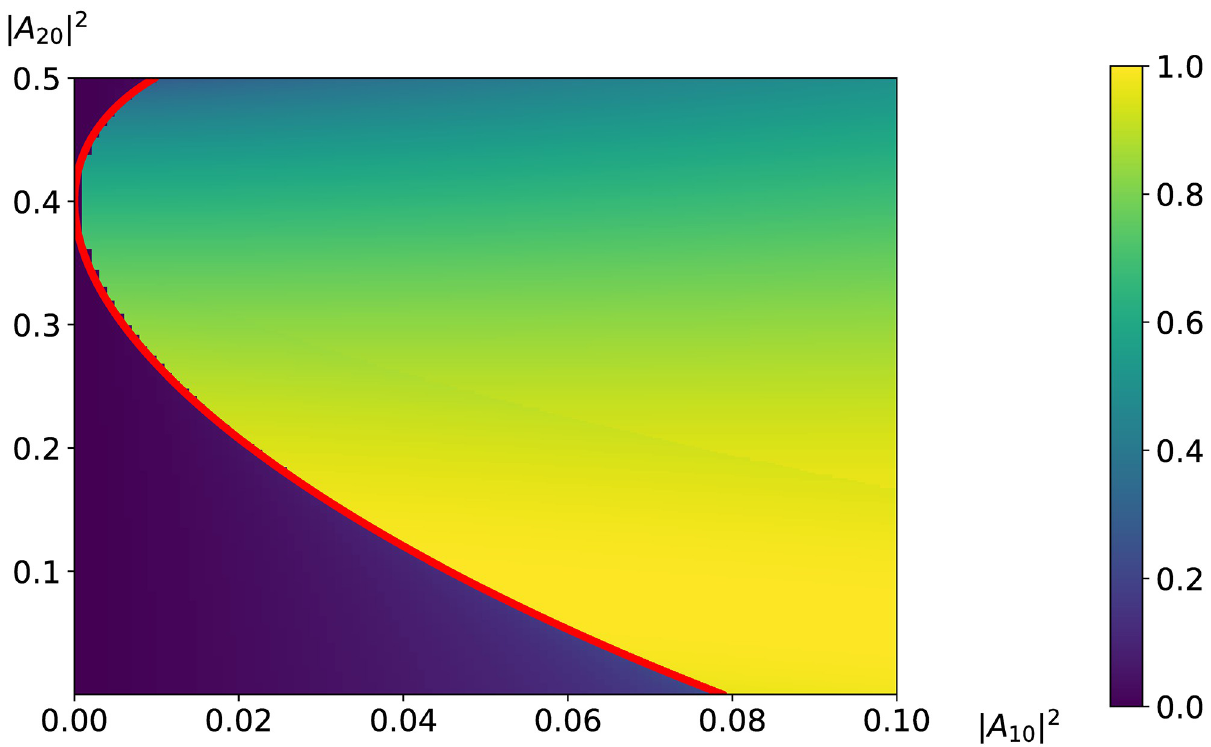
Fig 3. Dependence of the LFW maximal intensity on the incident LFW intensity and the incident IFW intensity. The boundary between high- effective mode and low-effective mode is depicted with red solid line.